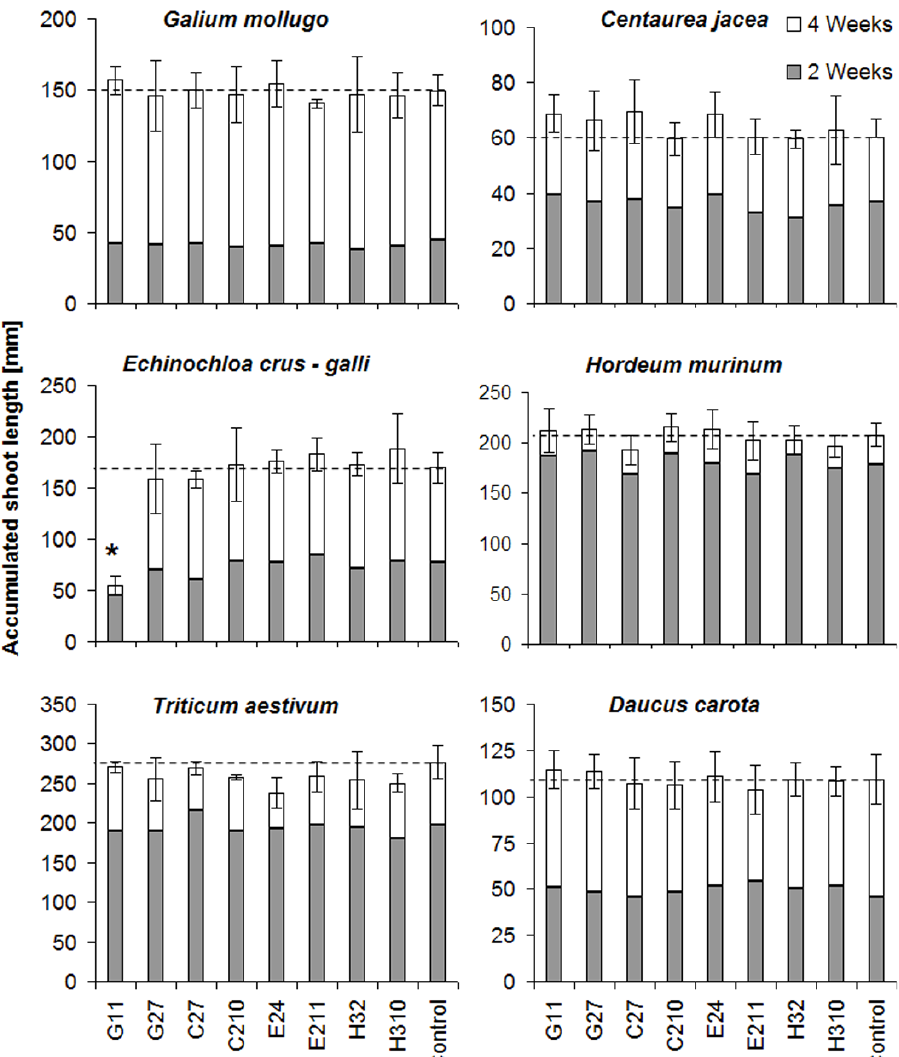
Figure 2. Influence of rhizobacteria inoculation on the shoot height of the model plants. Influence of eight rhizobacterial strains on the shoot height of four weed and two crop species after 2 and 4 weeks. The dotted line marks the average height of the plants in the control pots that did not receive rhizobacteria. The error bars indicate the standard deviation of the means (n=4). * This bacterial strain x plant species combination differs significantly from all others ( a